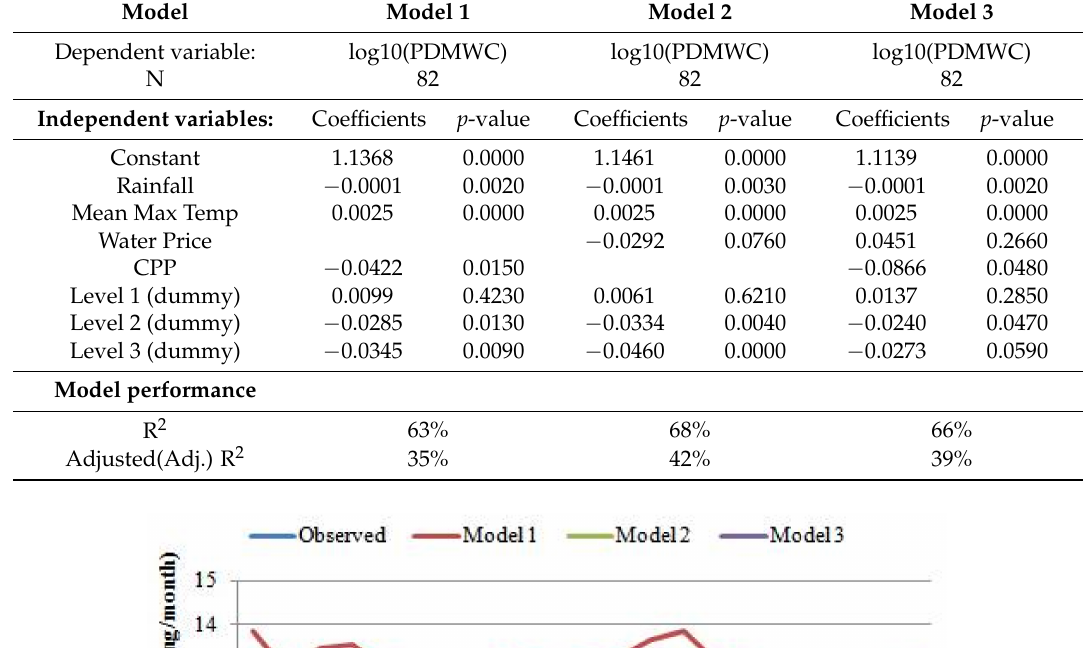
Table 4. Modelling results by the developed models adopting PCA analysis.